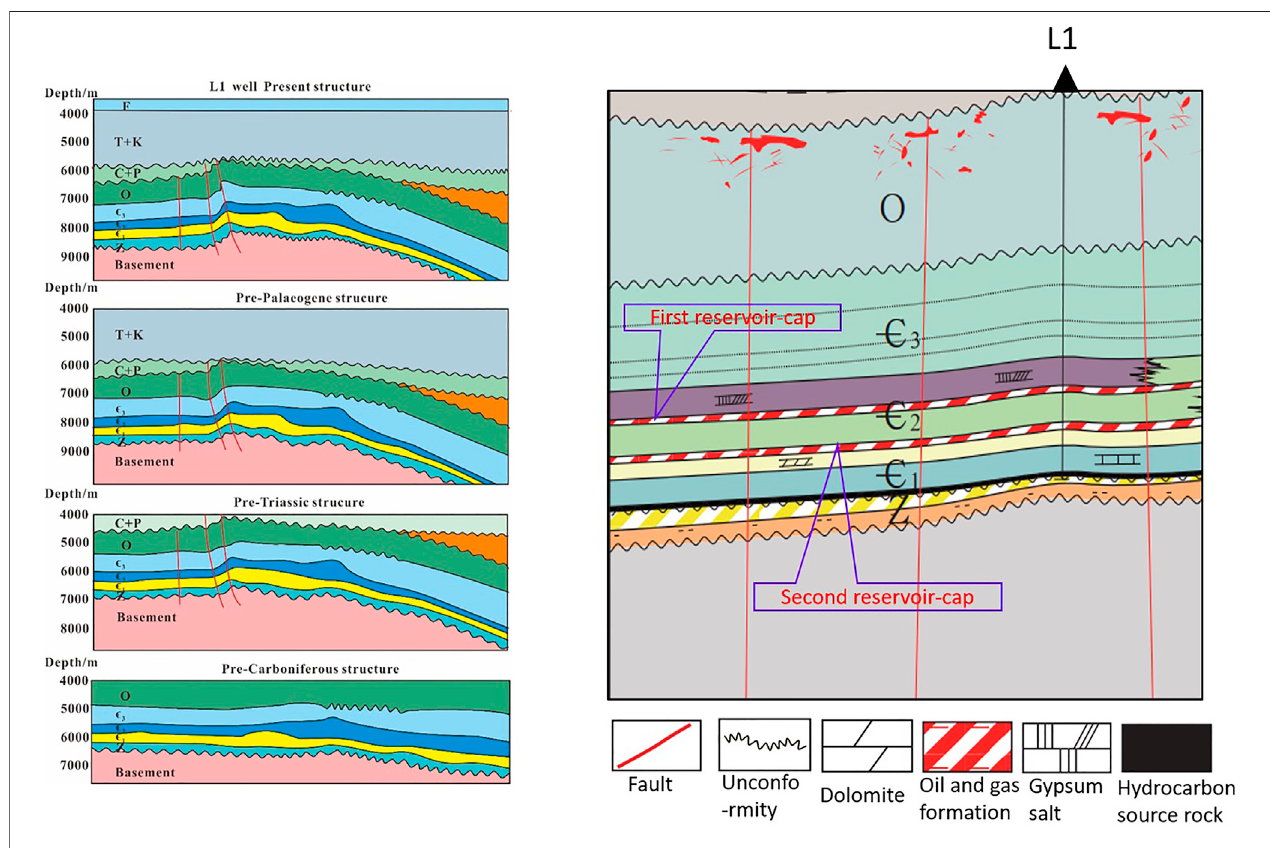
FIGURE 2 | Hydrocarbon accumulation mode of Well